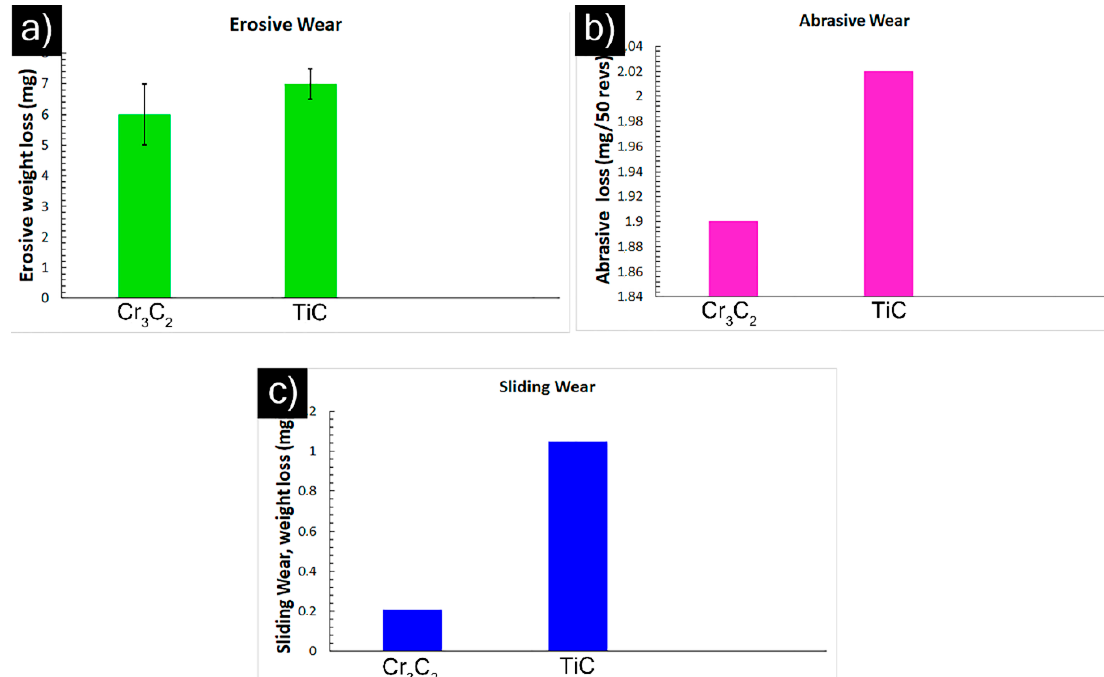
Figure 8. Performance of SPS-processed Cr 3 C 2 and TiC coatings under different wear modes: ( a ) erosion; ( b ) abrasion; and ( c ) sliding.